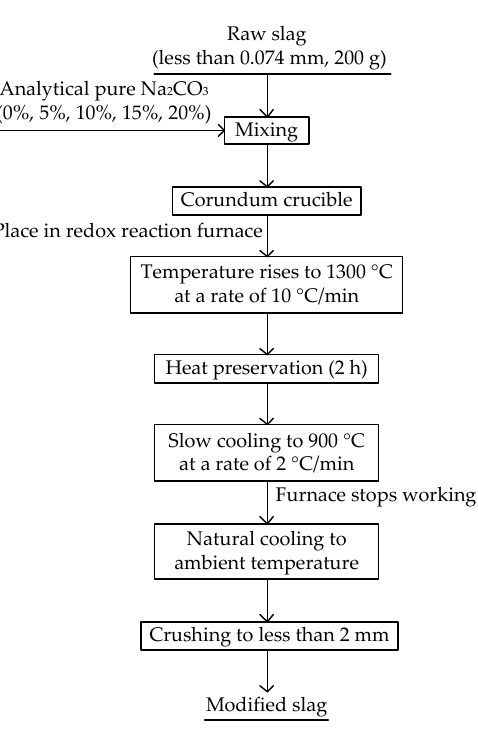
Figure 4. Melting modification test flowsheet of Cu slag.